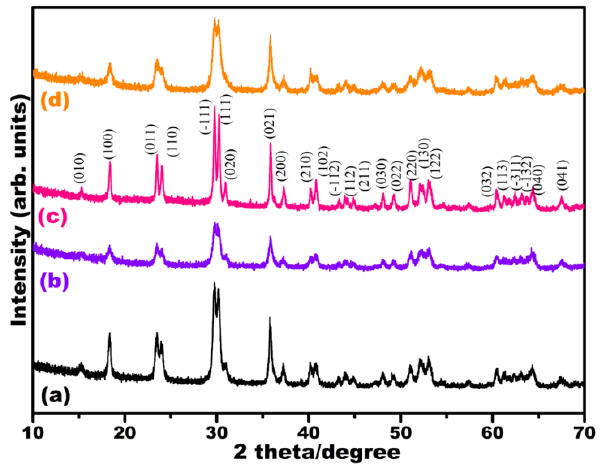
Figure 1. XRD patterns of the electrocatalysts, MW-7 ( a ), MW-12 ( b ), MW@GO-7 ( c ) and MW@.GO- 12 ( d ).